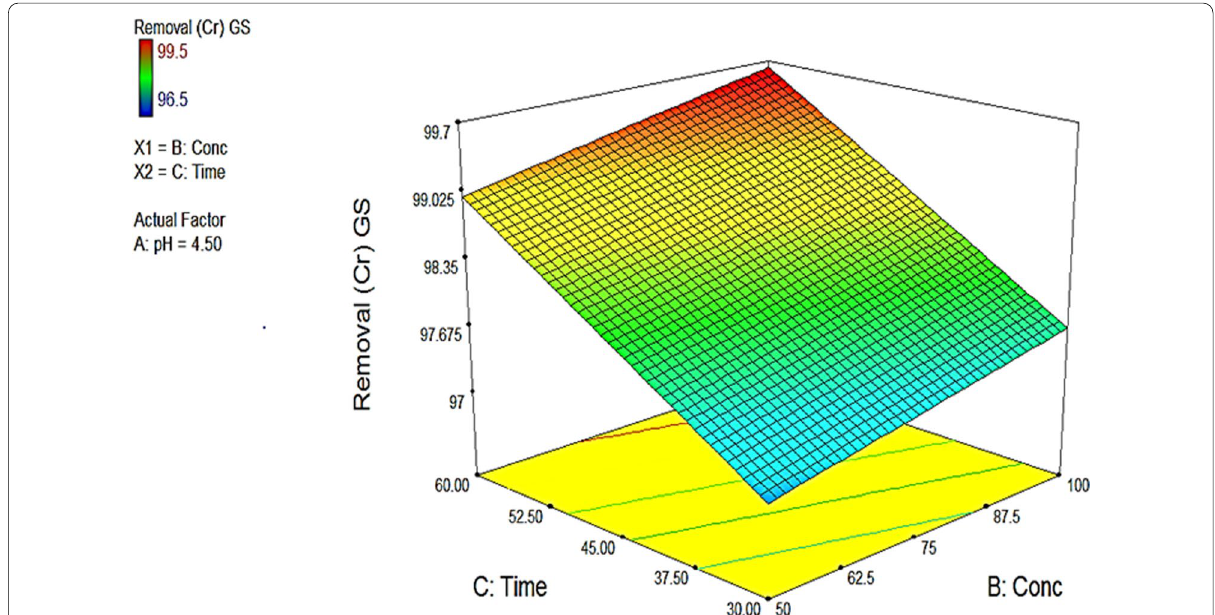
Fig. 8 A 3-dimensional plot of concentration and pH against the percentage removal of chromium when groundnut shell residues are used as adsorbent